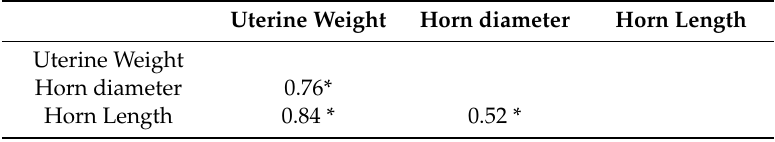
Table 4. Pearson’s correlation coe ffi cients between uterine traits at 160 days of age.